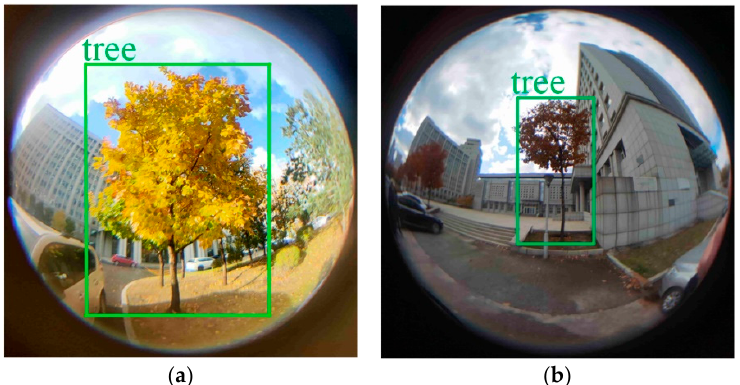
Figure 8. Fisheye image annotation under different weather conditions. ( a ) Sunny images annotation; ( b ) Cloudy images annotation.